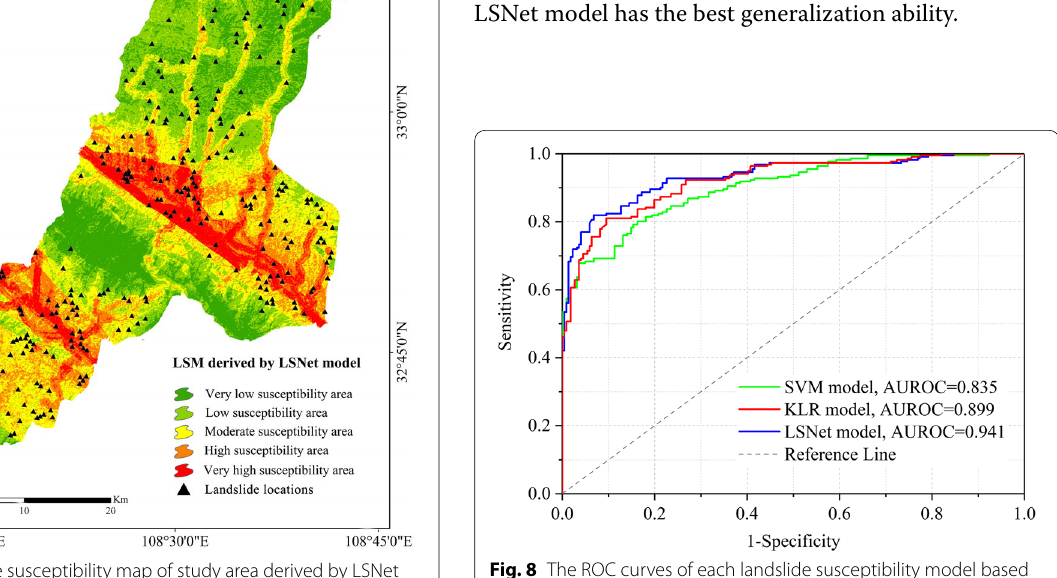
Fig. 7 Landslide susceptibility map of study area derived by LSNet model